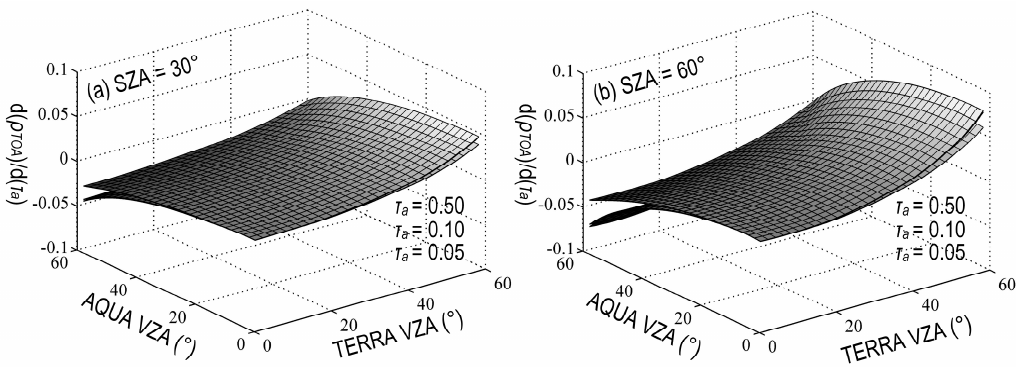
Figure 7. The effects of VZA difference on aerosol retrieval under different levels of AOT (AOT = 0.05; 0.10; 0.50) for ( a ) SZA = 30° and ( b ) SZA = 60°.